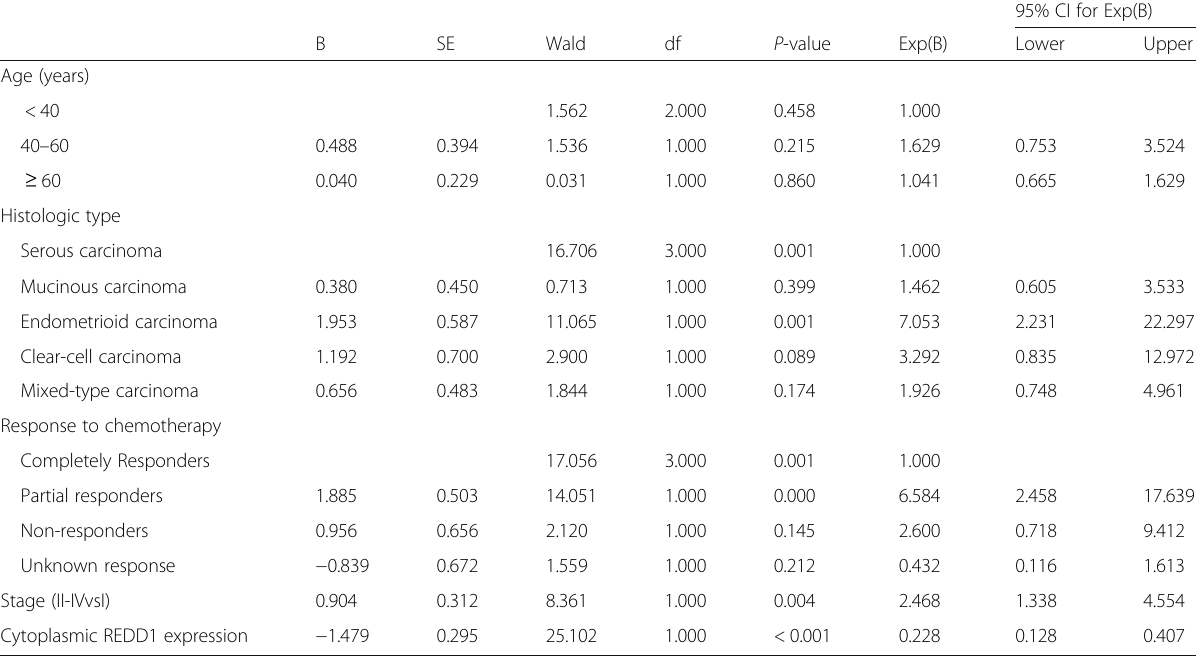
Table 7 The multivariate Cox proportional- hazards regression for